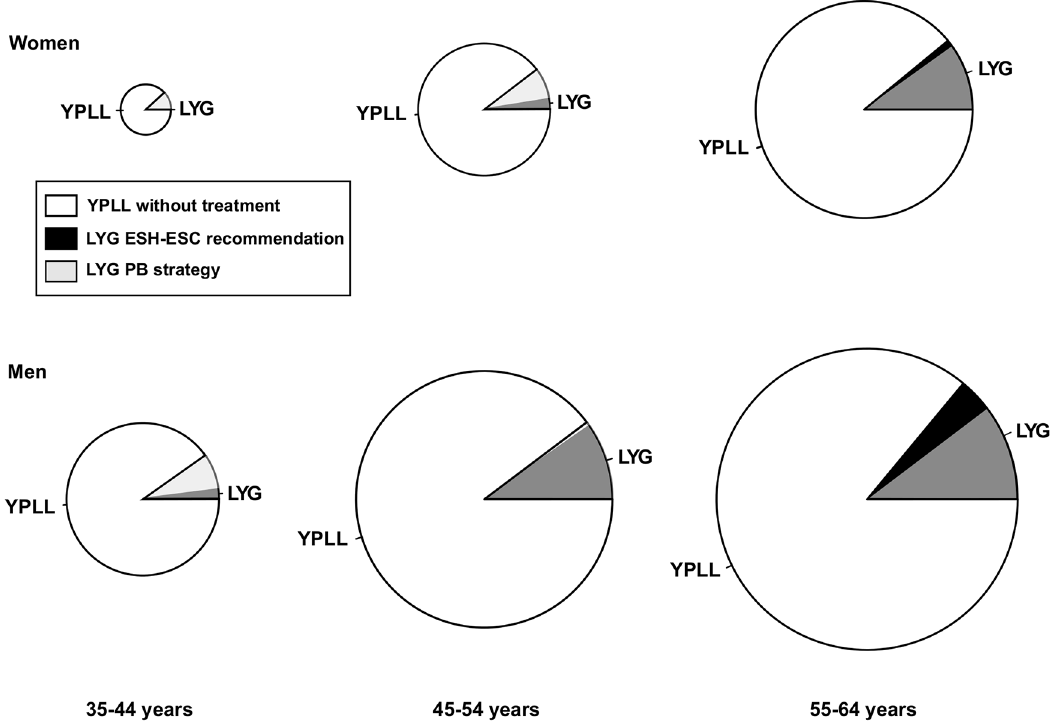
Fig 4. Rates of life-years gained referred to the rates of years of potential life lost by age classes obtained with the PB strategy and the 2007 ESH/ ESC guidelines. Pie areas represent the LYG rates on treatment referred to rates of YPLL if no treatment were administered among the individuals potentially eligible within each sex and age category. Gains for either treatment strategy are shown together and partly overlapped in all categories except for women younger than 45 years. Pie radii scale indicates the age-related gradient of YPLL.